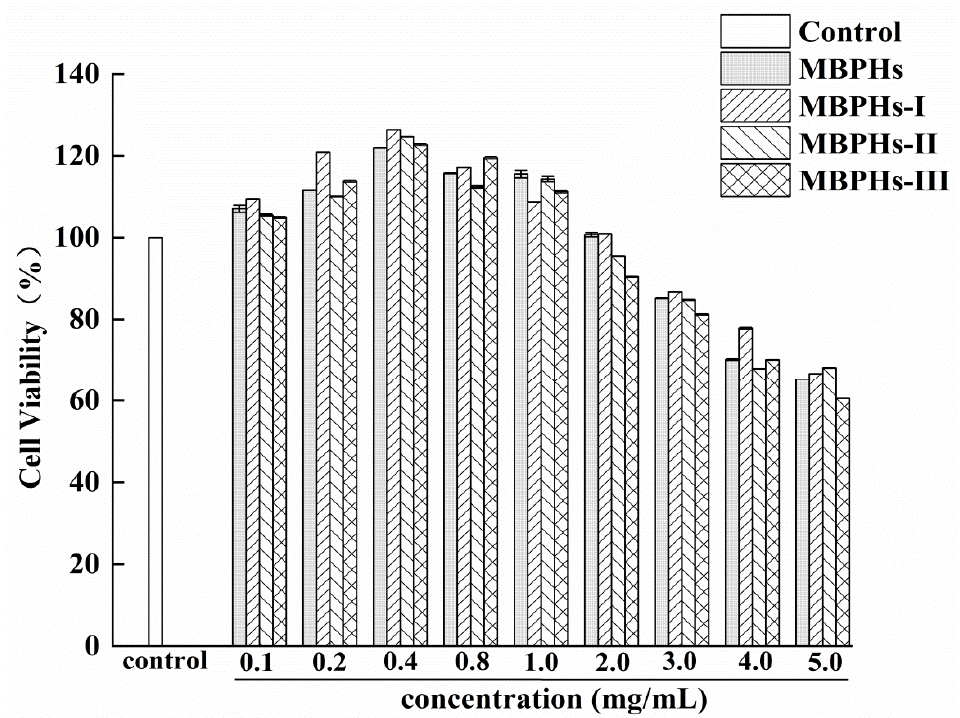
Figure 2. Evaluation of toxicity of mung bean protein hydrolysates (MBPHs), MBPHs-I, MBPHs-II, and MBPHs-III on the injured NCTC-1469 cells. Results are expressed as means ± SD ( n = 6).